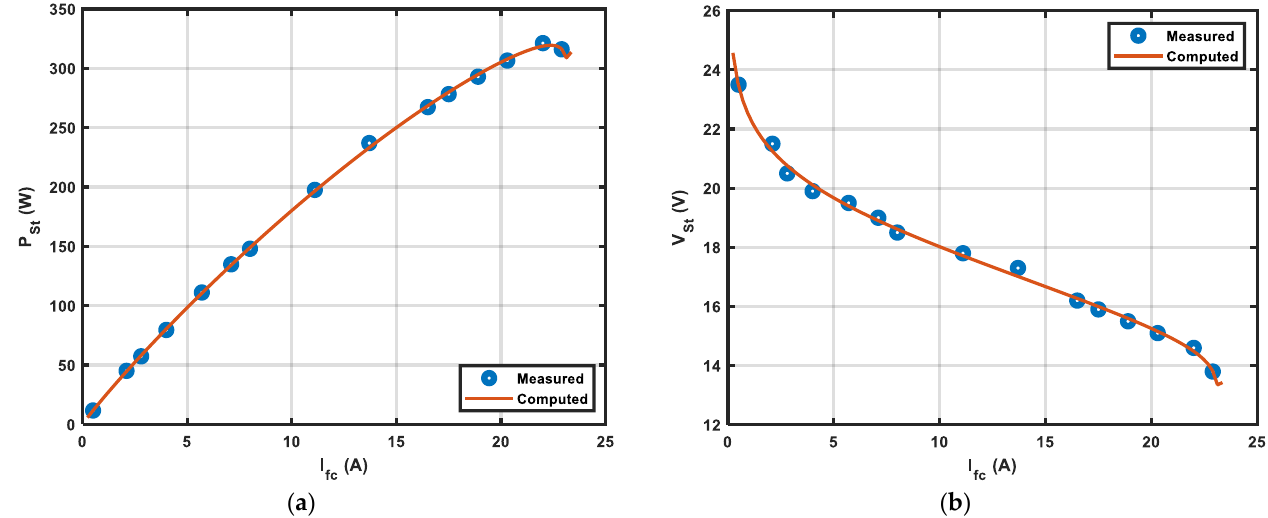
Figure 6. Comparison among algorithms in terms of five-number summary (boxplot), convergence speed, and CPU time on test case 2: ( a ) boxplot of the obtained outcomes, ( b ) CPU time, ( c ) convergence curve.